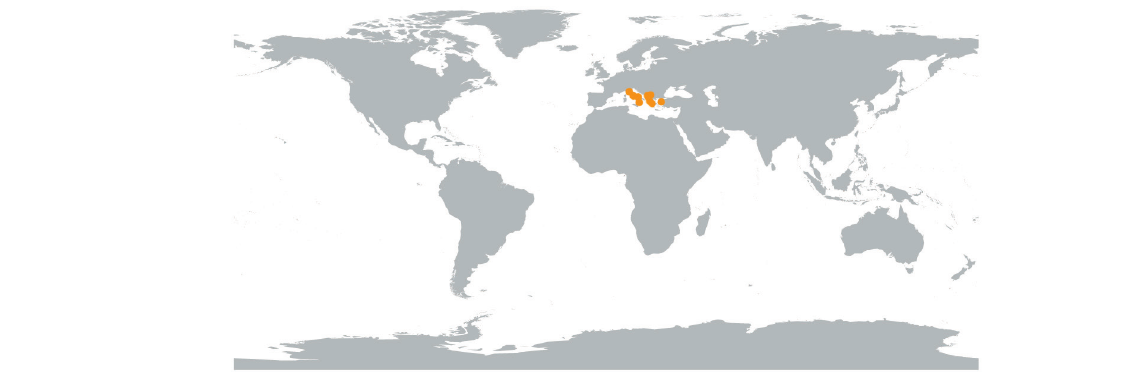
Fig. 53. Distribution of Malus florentina (Zuccagni) C.K.Schneid.